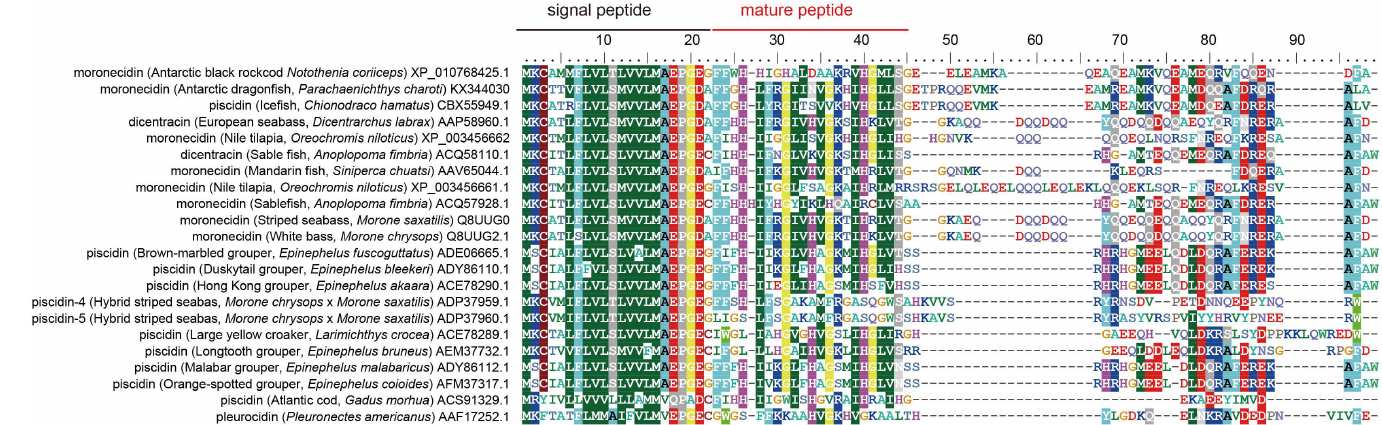
Fig 1. Alignment of the two novel moronecidin-like peptides with other known piscine AMPs. The signalpeptidesand mature peptidesof AMPs are well conserved in fish species.Accessionnumber: dicentracin (Europeanseabass, Dicentrarchus labrax )AAP58960.1; moronecidin (Nile tilapia, Oreochromis niloticus )XP_003456662; dicentracin (Sablefish, Anoplopoma fimbria )ACQ58110.1; moronecidin (Mandarinfish, Sinipercachuatsi )AAV65044.1; moronecidin (Nile tilapia, Oreochromisniloticus )XP_003456661.1; moronecidin (Sablefish, Anoplopoma fimbria )ACQ57928.1; moronecidin (Stripedseabass, Morone saxatilis )Q8UUG0; moronecidin (White bass, Moronechrysops )Q8UUG2.1; piscidin(Brown-marbledgrouper, Epinephelusfuscoguttatus ) ADE06665.1; piscidin(Duskytail grouper, Epinephelus bleekeri )ADY86110.1; piscidin(HongKong grouper, Epinephelus akaara )ACE78290.1; piscidin(Hybrid striped seabass, Moronechrysops × Moronesaxatilis )ADP37959.1; piscidin(Hybrid stripedseabass, Morone chrysops × Morone saxatilis ) ADP37960.1; piscidin (Largeyellowcroaker, Larimichthys crocea )ACE78289.1; piscidin(Longtooth grouper, Epinephelus bruneus )AEM37732.1;